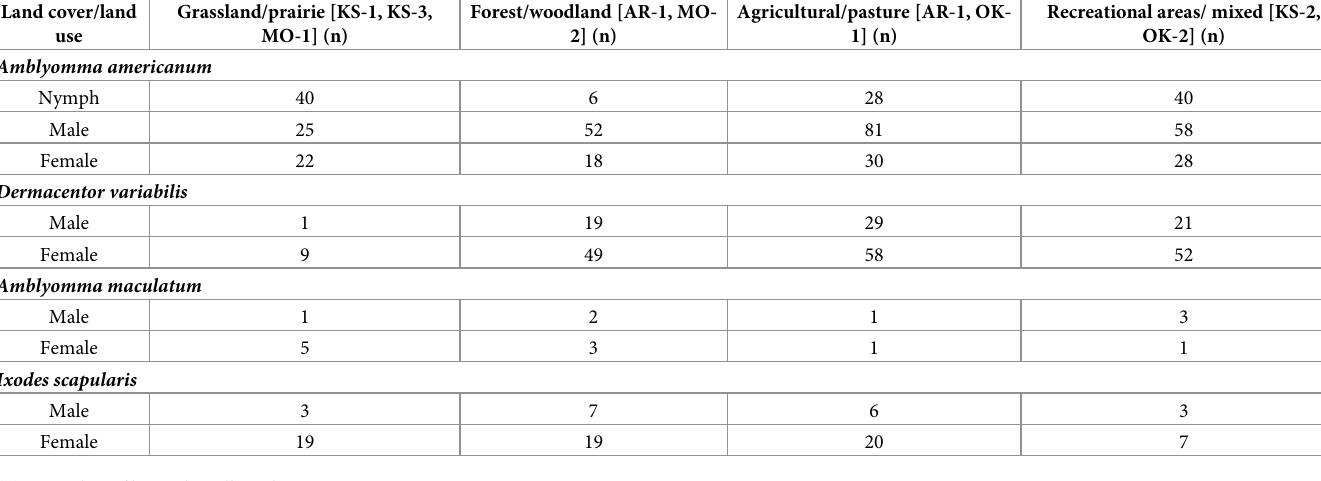
Table 5. Number of ticks caught in different land cover/land use types. Land cover/land Grassland/prairie [KS-1, KS-3, use MO-1] (n)